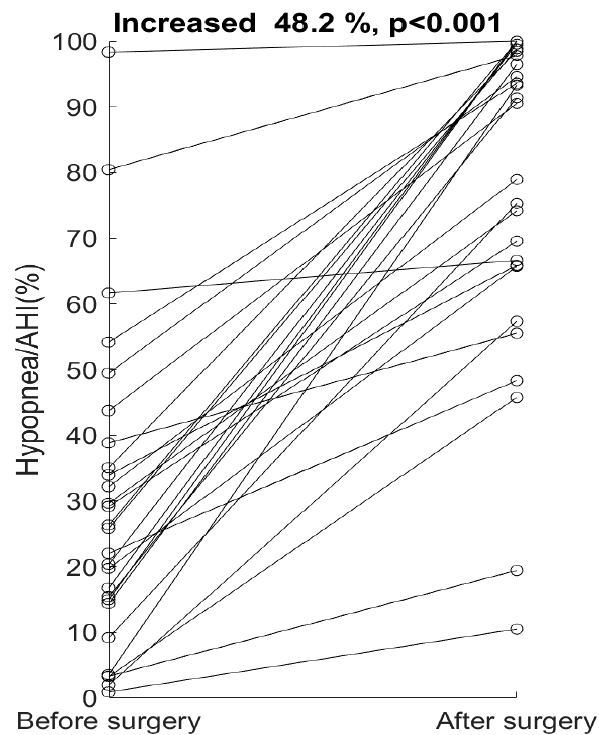
Figure 4. Individual portion change of hypopnea in AHI. After the surgery, the mean hypopnea portion increased 48.2%, p < 0.001.